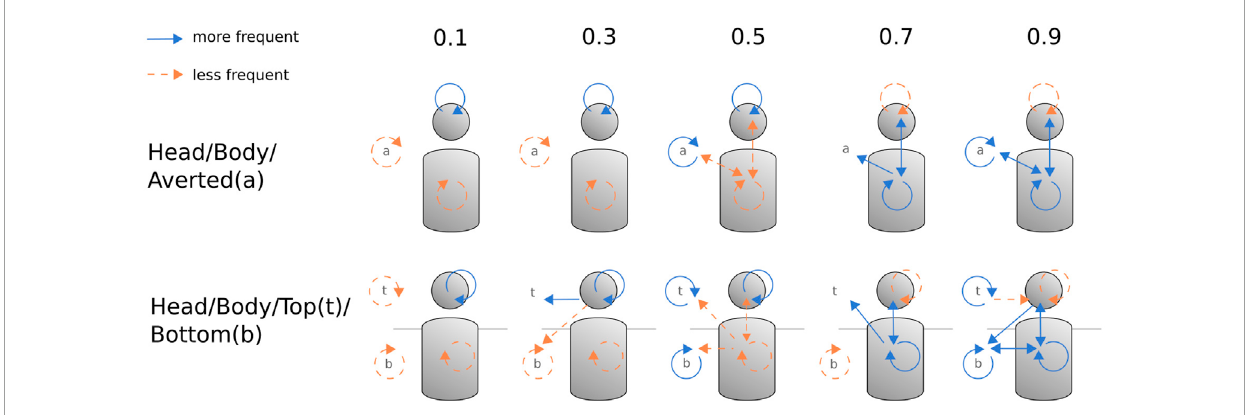
FIGURE 7 Visualization of significant deviations from the expected gaze transition frequencies in the 5 GAR conditions. Top: ROIs head, body, gaze averted. Bottom: ROIs head, body, top, and